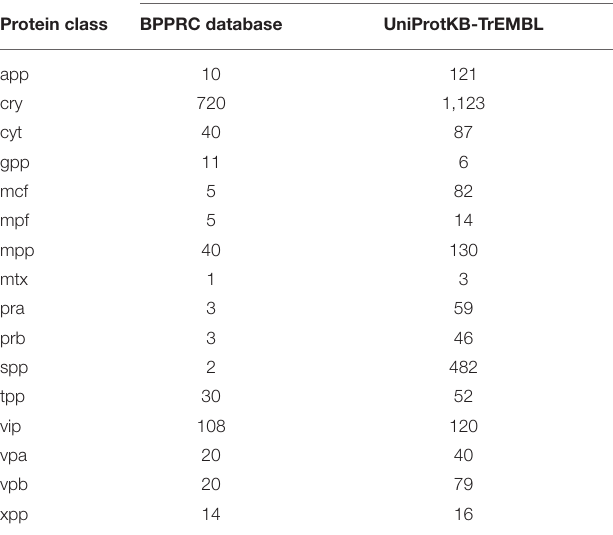
TABLE 2 | Protein sequences identified by IDOPS profile HMMs in UniProtKb-TrEMBL compared with the amount of sequences at the Bacterial Pesticidal Protein Resource Center